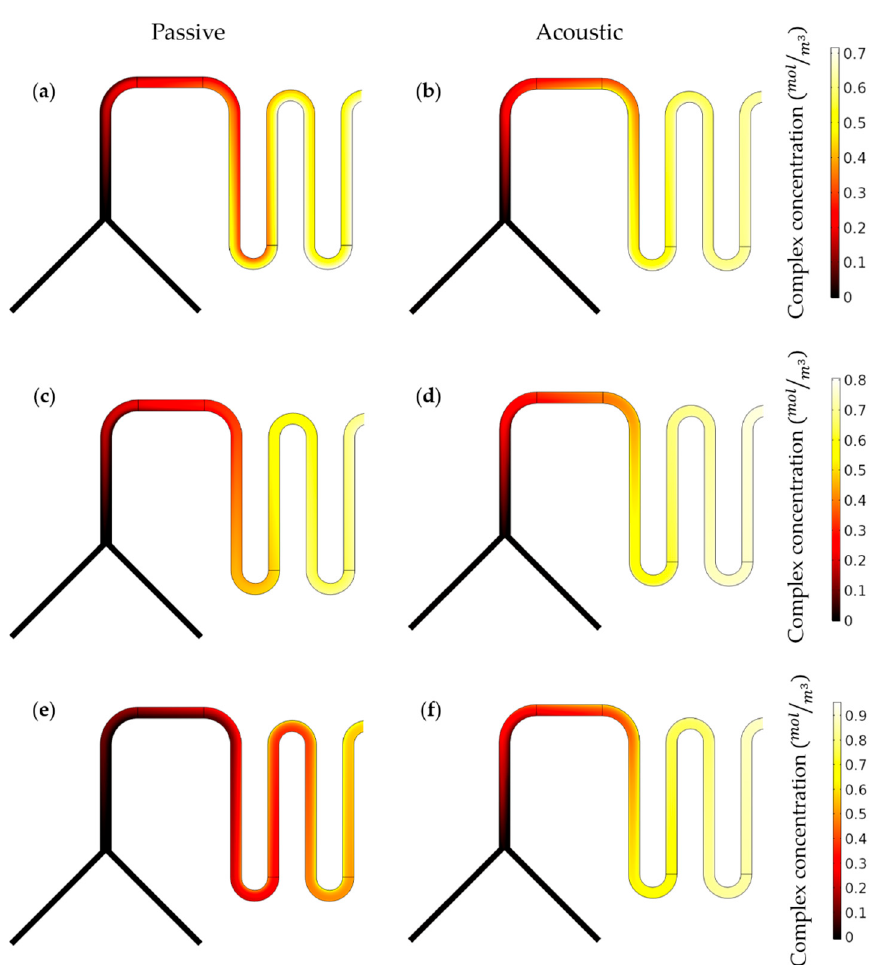
Figure 8. Comparison between passive and acoustic encapsulation at different FRRs as measured by the concentration of the liposome–MNP complex. ( a , b ) FRR = 1:1; ( c , d ) FRR = 1:2; ( e , f ) FRR = 1:3. FRRs given as MNP:liposome ratios.